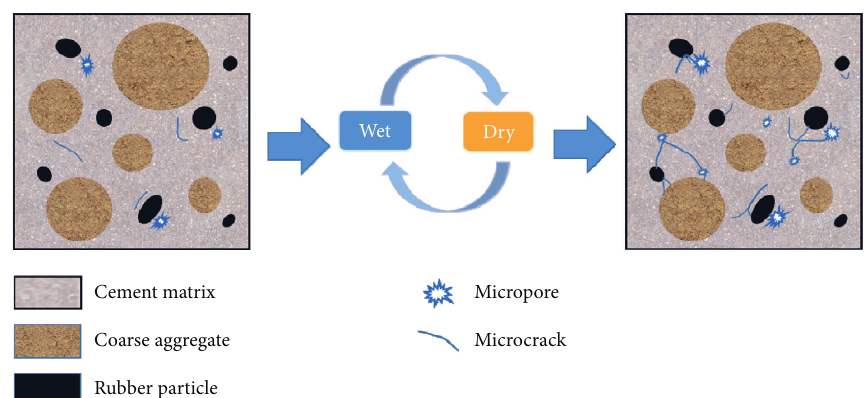
Figure 12: The internal structure schematic diagram of RC subjected to different wet-dry cycles.